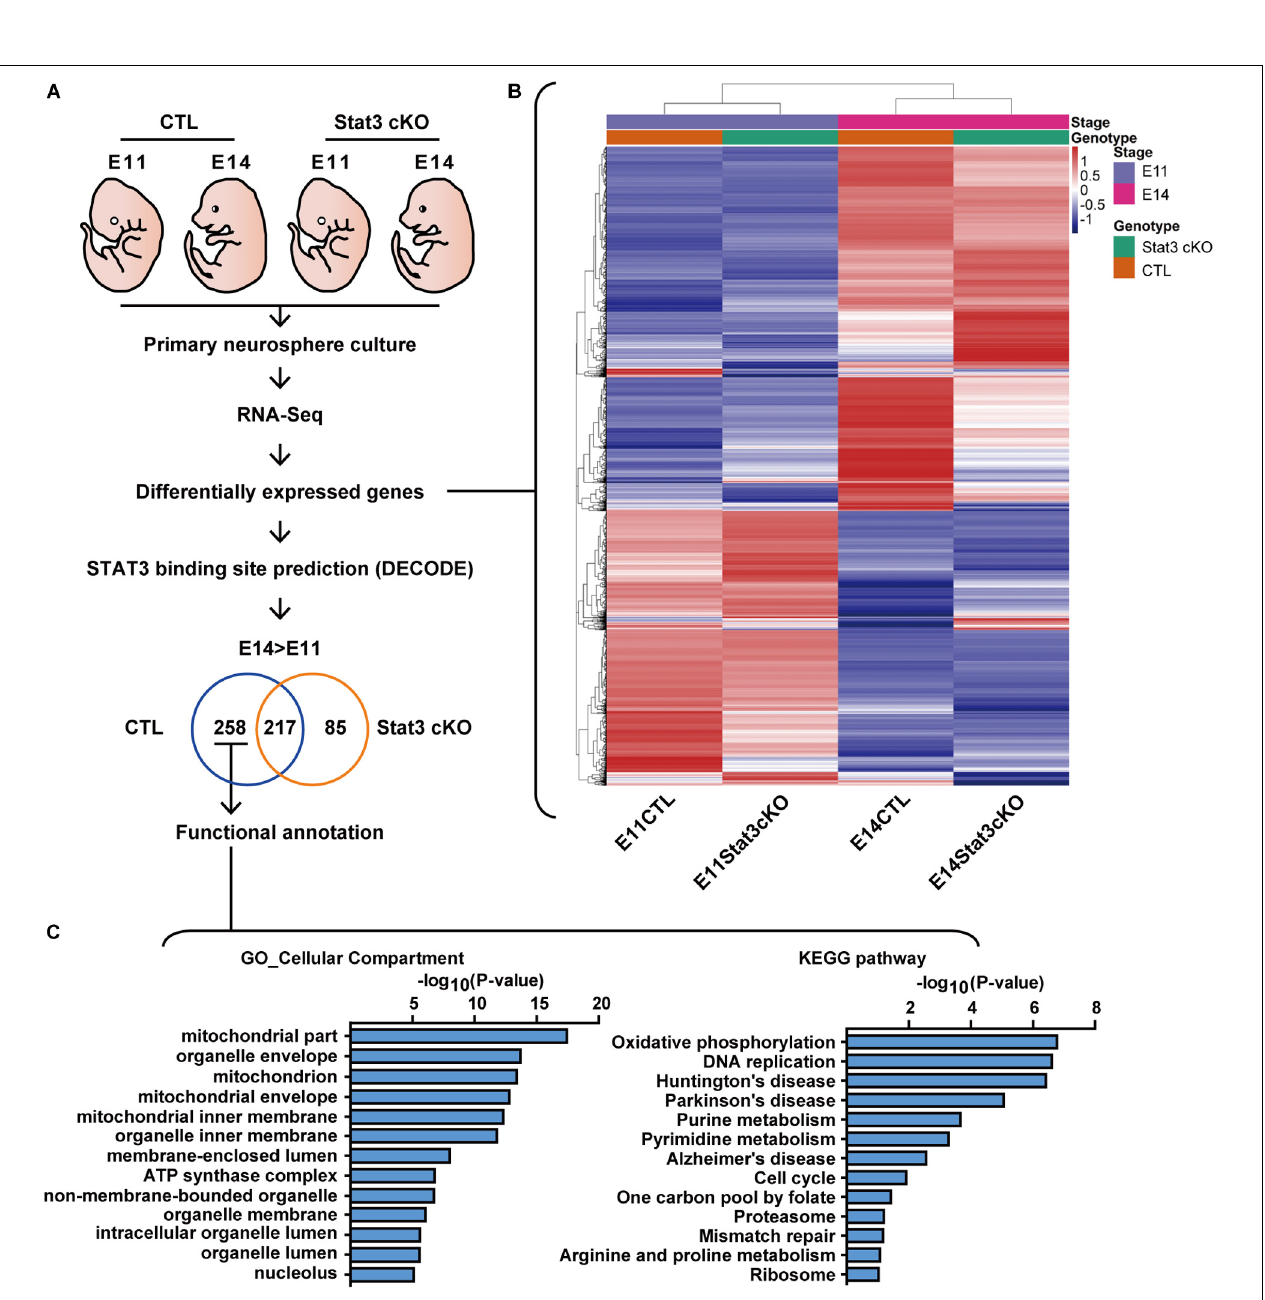
FIGURE 2 | RNA-seq revealed that STAT3 promotes the expression of genes involved in mitochondrial metabolism. (A) Experiment scheme of RNA-seq experiment. (B) Heatmap of the differentially expressed gene between four experiment groups. (C) Functional annotation of genes upregulated between E11 and E14 in CTL compared to Stat3